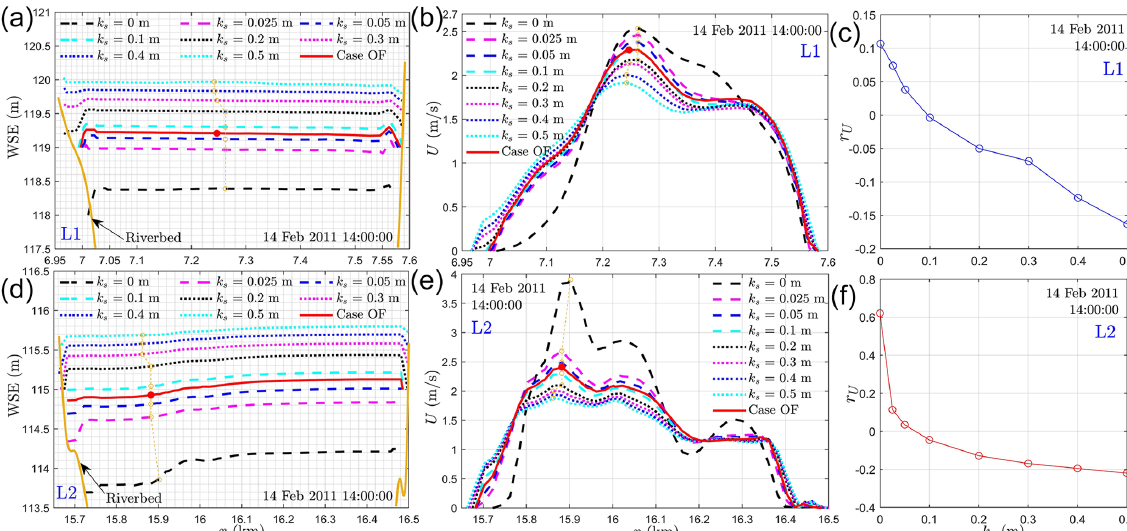
Figure 12. The spatial variations of water surface elevation (a, d) and free-surface velocity magnitude (b, e) under different roughness heights at transects L1 and L2 (see Fig. 1c) as well as the relative error (c, f) of the maximum free-surface velocity at each roughness height. Dashed circle lines and red dots in panels (a) – (b) and (d) – (e) denote the locations where the maximum velocity magnitude is reached. The r U in panels (c) , (f) is defined as the relative velocity difference between the yellow circles and red dots in panels (b) , (e)